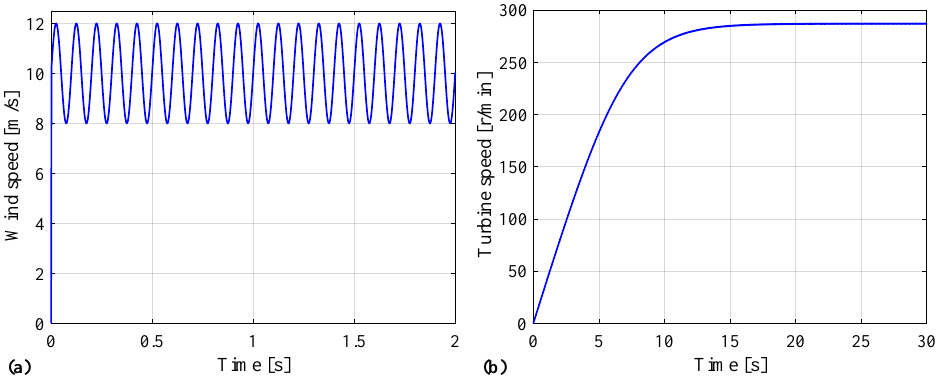
Figure 18. ( a ) Wind speed input of 10 Hz and ( b ) turbine (generator) speed response versus time.